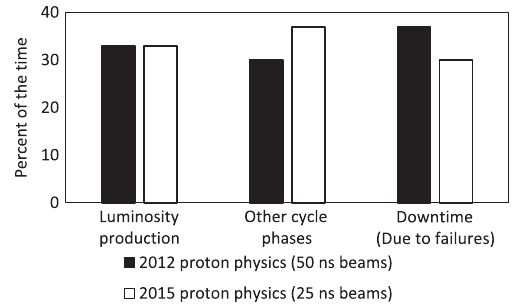
FIG. 6. LHC operational statistics for 2012 [3] and for 2015